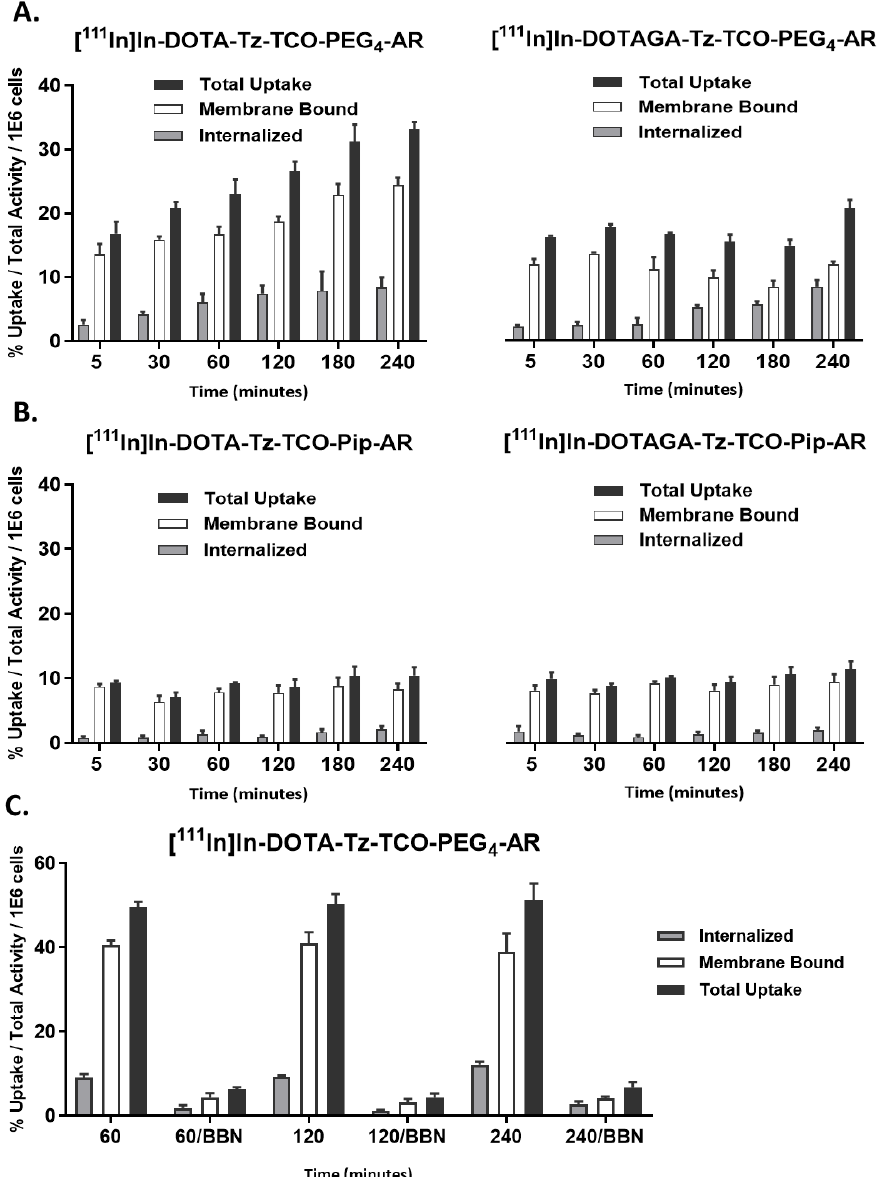
Figure 4. Time-dependent cellular uptake, surface-bound and internalization of the radioconjugates in PC3 cells at 37 °C. ( A ). [ 111 In]In-DOTA-Tz-TCO-PEG 4 -AR and [ 111 In]In-DOTAGA-Tz-TCO-PEG 4 -AR. ( B ). [ 111 In]In-DOTA-Tz-TCO-Pip-AR and [ 111 In]In-DOTAGA-Tz-TCO-Pip-AR. ( C ). [ 111 In]In-DOTA-Tz-TCO-PEG4-AR co-incubated with or without the GRPR agonist Tyr4-Bombesin (0.25 µg/0.5 mL/well). The results are expressed as a percentage of the total (applied) activity (mean ± SD; n = 4).